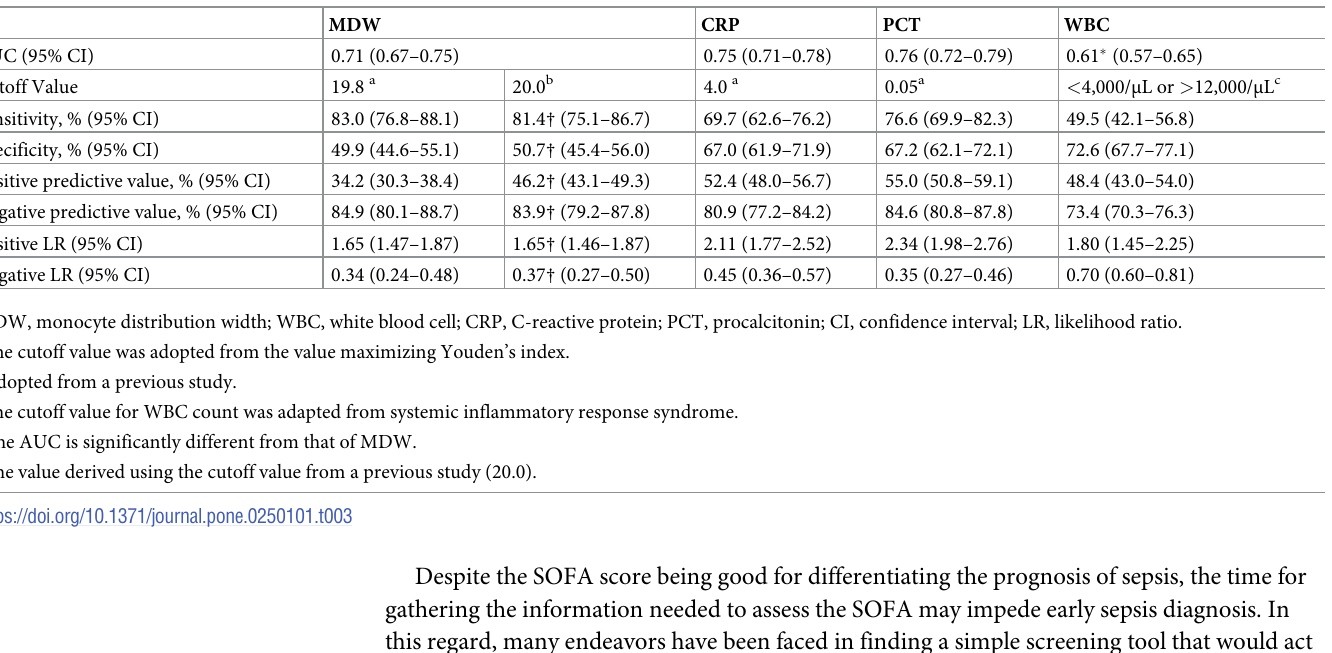
Table 3. Diagnostic performance of WBC count, CRP, PCT, and MDW in predicting sepsis (by Sepsis-3 definition).